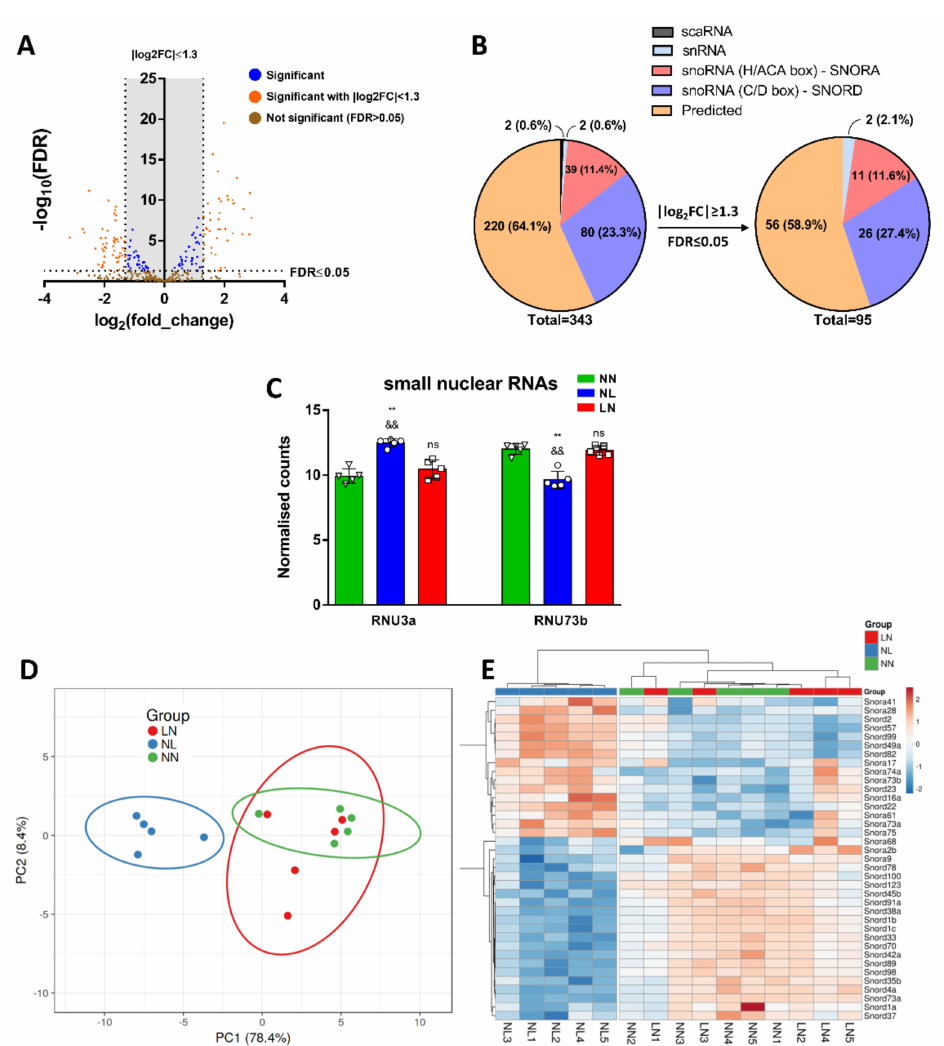
Figure 6. Bioinformatic analyses of differentially expressed sn/snoRNAs. Small RNA-seq data analysis revealed DE of multiple snRNAs and snoRNAs, as shown in the Volcano plot ( A ). Filters application of FDR ≤ 0.05 and |log2FC| ≥ 1.3 indicated